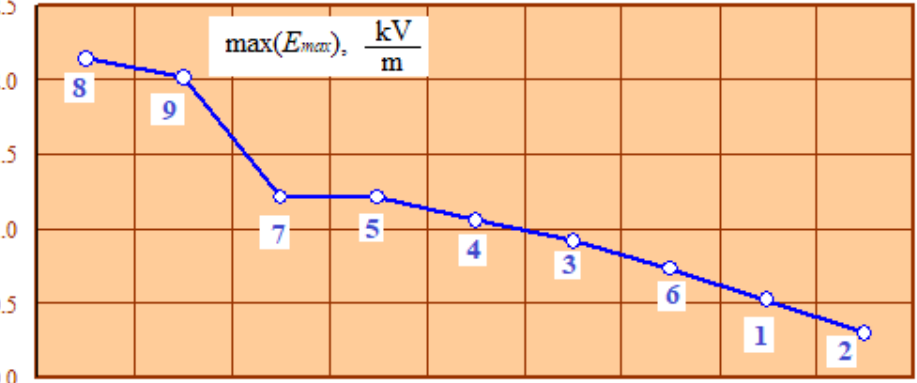
Figure 21. Maximum amplitudes of the electric field at the starting end of the transmission line 5—callout numbers correspond to those in Figure 15.